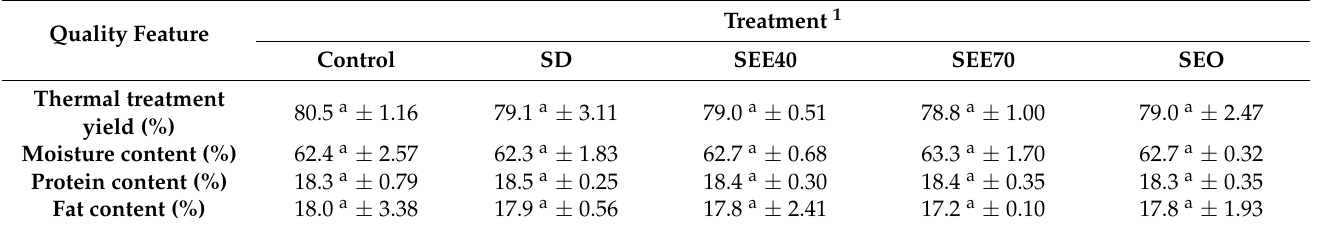
Table 1. Thermal treatment yield and chemical composition of chicken meatballs containing MSM from chickens (mean values ± standard deviation; n =